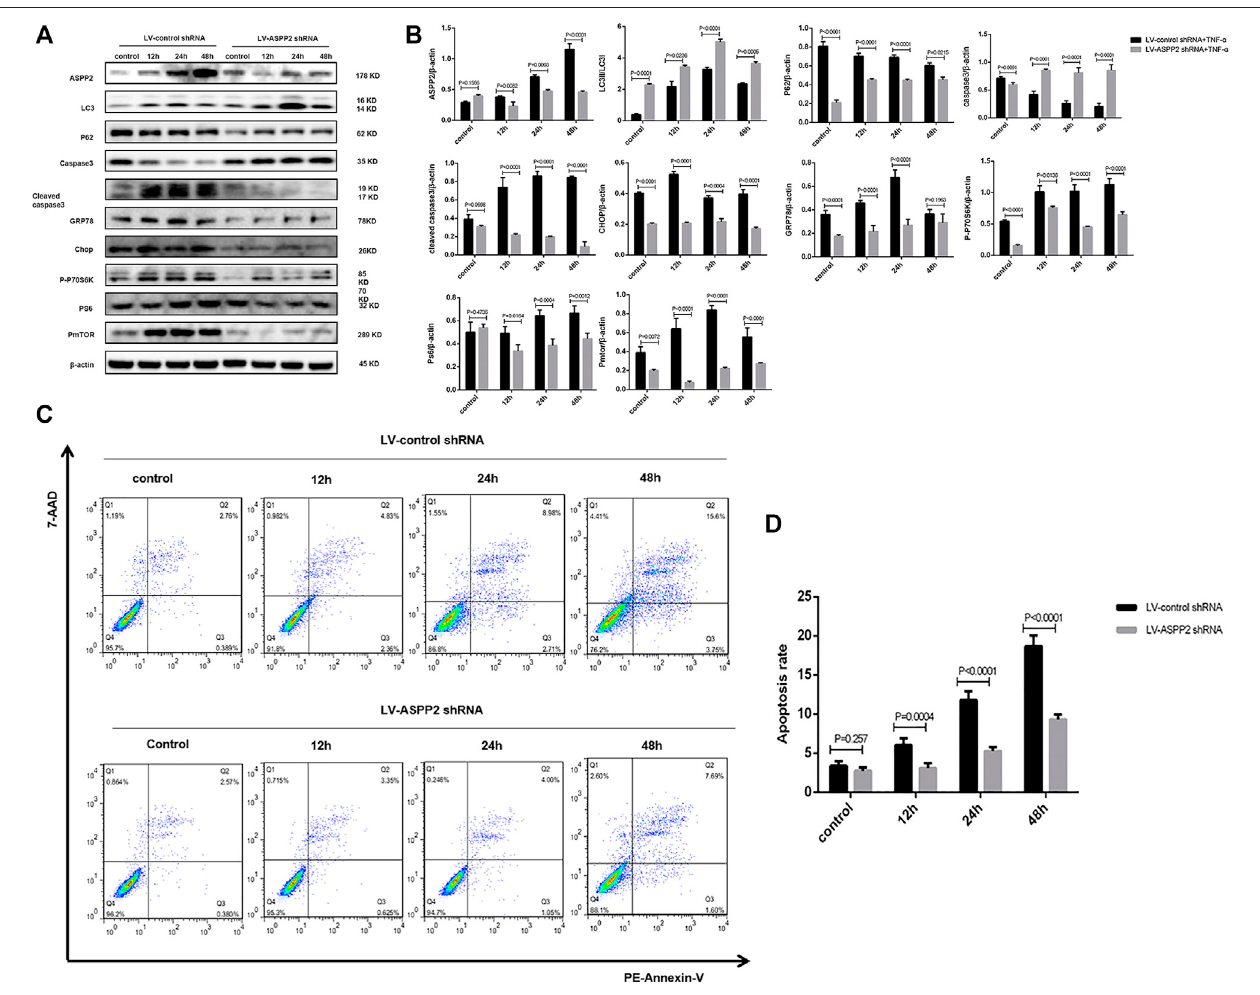
FIGURE 3 | ASPP2 inhibition downregulated mTORC1 and enhanced autophagy, but inhibited apoptosis in case of hepatocyte injury induce by TNF- α . HL7702 cellsweretransfected byLV-ASPP2shRNAorLV-controlshRNAandtheninducedbyTNF- α (25 ng/ml)for12,24,and48 h,respectively. (A,B) Representativewestern blotting analysis was conducted of protein expression in HL7702 cells after treatment. Quanti fi cations were normalized to β -actin and expressed as relative density. (C,D) Representativeapoptosisimageswerepresented withPEand7-AADreagentsby fl owcytometry.Theapoptosisratewascalculatedusingtheproportionof early and late apoptotic cells in total